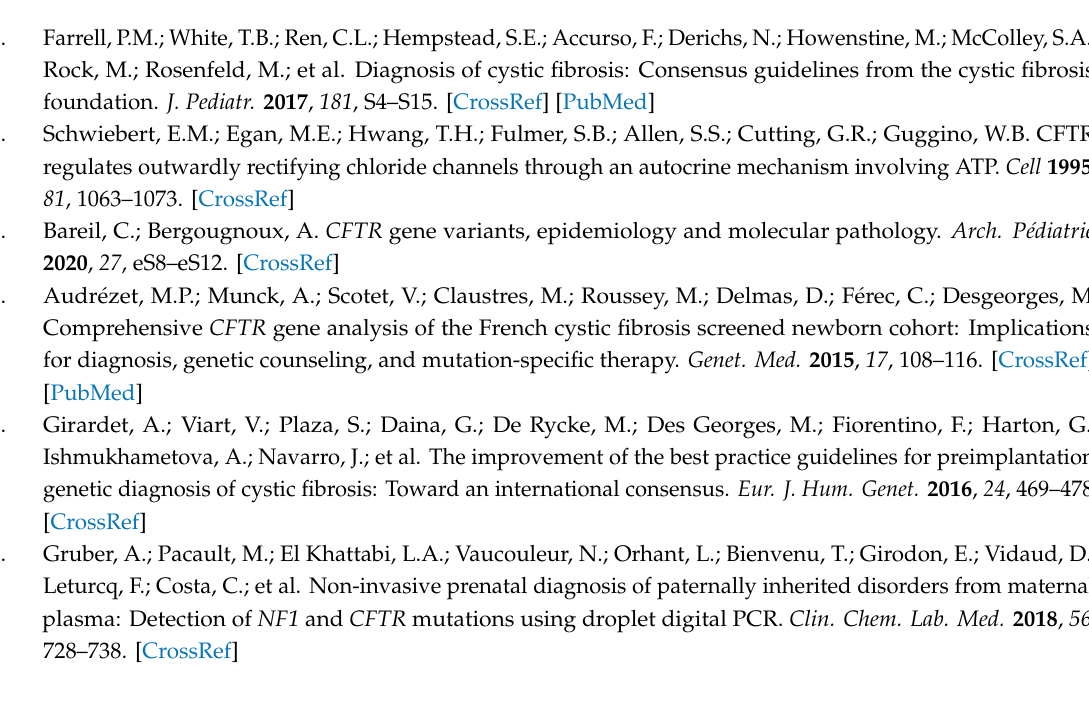
Table S1. Sensitivity of the ACMG recommended CF-causing variant panel for CF carrier screening in di ff erent countries and ethnic populations. ACMG: American College of Medical Genetics. Allelic frequencies among CF alleles are indicated in percentage. 0 (cells in grey) indicates that the variant was absent in the population tested. Table S2: Frequency in di ff erent countries of non-F508del variants approved for CFTR modulator therapy. * Variants approved by Food and Drug Administration (FDA) for ivacaftor in a first list and ** in the second list. Variants approved by European Medicines Agency (EMA) are in grey; £ Variants approved by FDA for tezacaftor / ivacaftor when in combination with F508del; § Variants approved by EMA for tezacaftor / ivacaftor; 0 indicates that the variant was absent in the population tested; nd*: frequency < 0.01%. The total does not reflect the approval in each